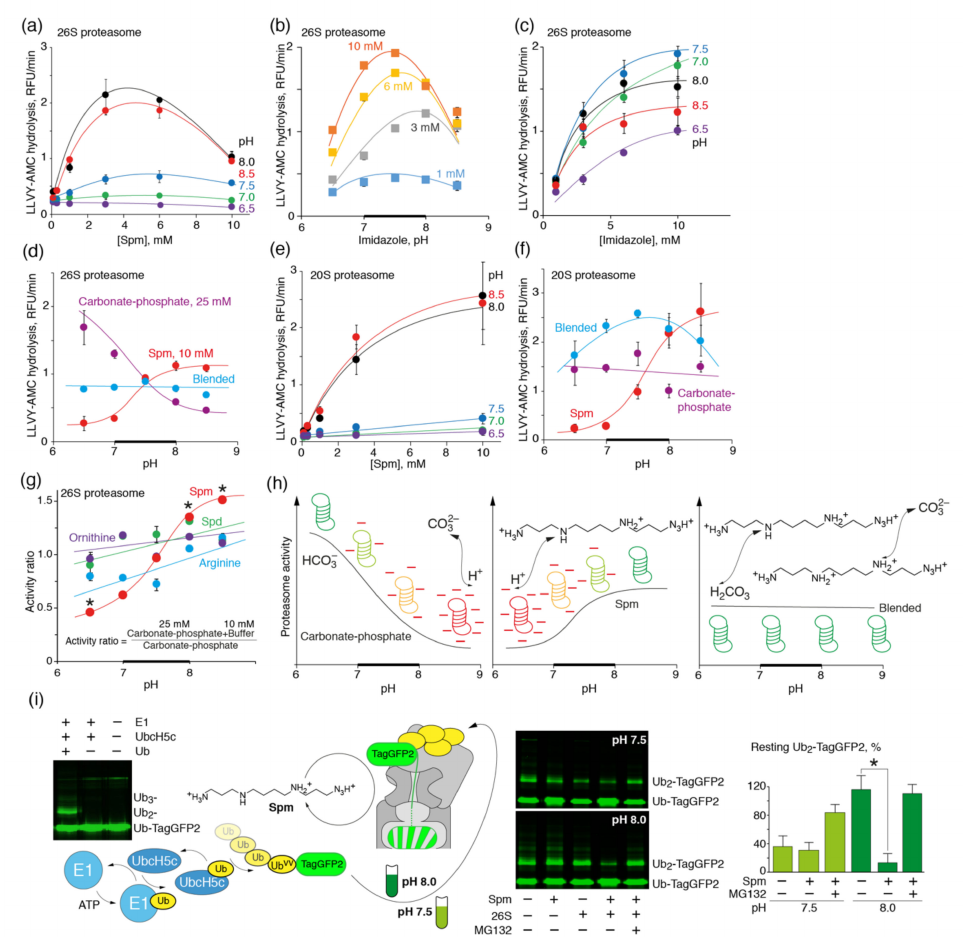
Figure 4. Spermine enhances the proteasomal chymotrypsin-like peptidase activity in a pH-dependent manner and counteracts carbonate-driven proteasome stalling at an alkaline pH. Chymotrypsin-like activity of the 26S ( a , d ) or 20S ( e , f ) proteasomes was measured at different pH and Spm concentrations ( a , e ) or at different pH in the amine buffer systems ( d , f ) containing 25 mM carbonate–phosphate (24:1) (violet), 10 mM Spm (red) or their mixture (cyan). ( b , c ) The pH dependence of the proteasomal chymotrypsin-like peptidase activity in the buffers containing various concentrations of imidazole at different pH. Activity of the 26S proteasome was measured using Suc-LLVY-AMC at the indicated concentrations of imidazole and pH values. The data represent the average and standard deviation (error bars) from four independent measurements. ( g ) Ratio of the chymotrypsin-like activity of the 26S proteasome measured in the 25 mM carbonate–phosphate buffer supplemented with 10 mM arginine (blue), ornithine (violet), Spd (green) or Spm (red) to the activity of the 26S proteasome measured in the 25 mM carbonate–phosphate buffer. Asterisks denote a statistically significant difference. The data were fitted to a polynomial square of an exponential or Gauss function and are shown as means ± SD (error bars) from triplicate determinations. ( h ) Deprotonation of the 26S proteasome by carbonate ions at an alkaline pH or by Spm at a neutral pH leads to proteasome inhibition. Simultaneous exposure of the 26S proteasome to Spm and carbonate results in proton transfer between bicarbonate and Spm at a neutral pH and protonation of carbonate ions by protons from Spm at an alkaline pH. The presence of Spm as a proton donor at alkaline pH protects the proteasome and thus preserves its activity. ( i ) Ub-TagGFP2 was ubiquitinated in vitro by a reconstituted E1-UbcH5c cascade and further mixed with the 26S proteasome at various pH levels in the presence or absence of Spm. Bars on the right represent the percentage of the di-ubiquitinated TagGFP2 hydrolyzed by the 26S proteasome compared with the control sample. Standard deviations are shown. The physiologically relevant pH range is shown by a bold